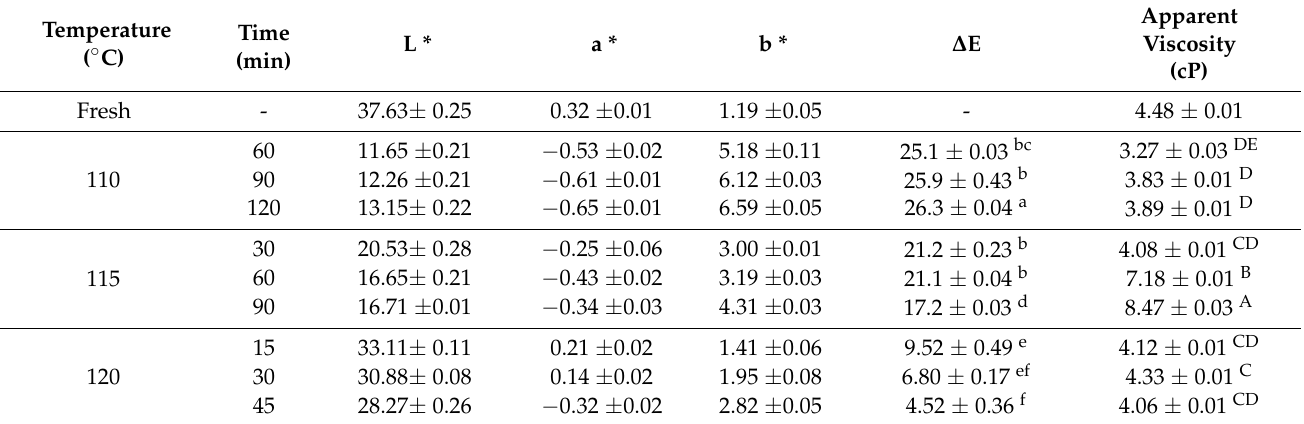
Table 4. L*, a* and b* values of soy slurry samples treated at different processing